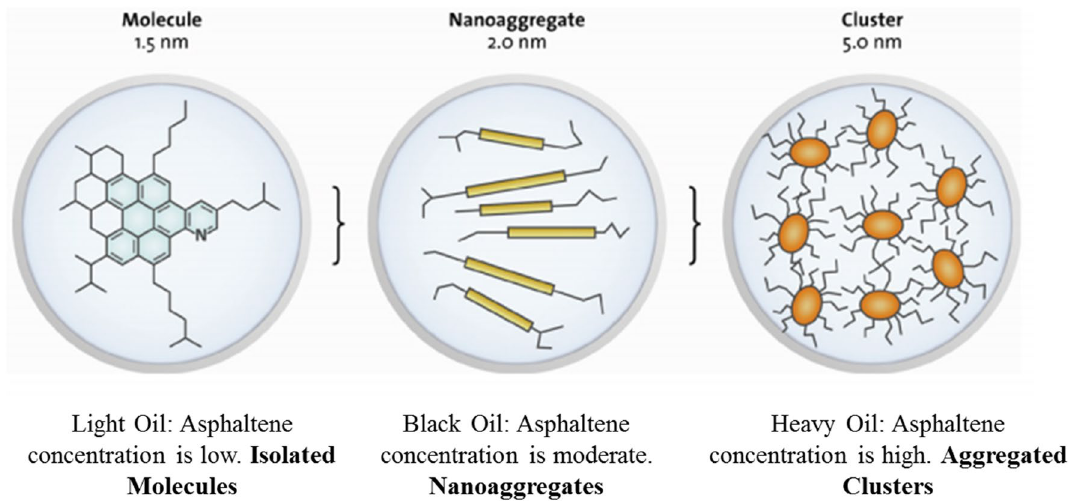
Fig. 9 Yen–Mullins asphaltene model (Mullins